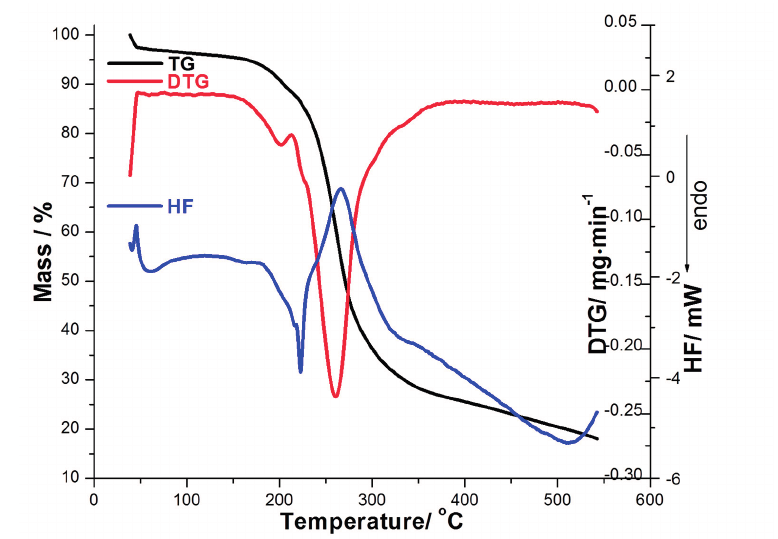
Figure 2. The thermoanalytical curves (TG/DTG/HF) recorded with β = 15 °C/min for SB1 derivative. TG: thermogravimetric; DTG: derivative thermogravimetry; HF: heat